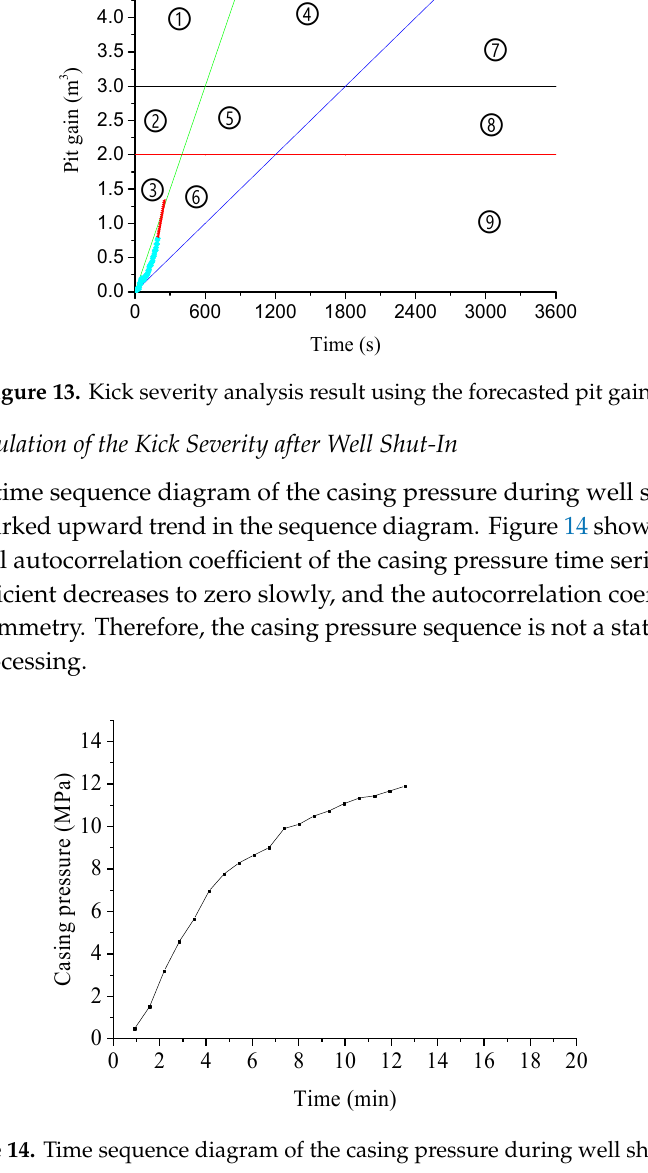
Table 7. Unit root test results of the casing pressure time series after the first-order difference.